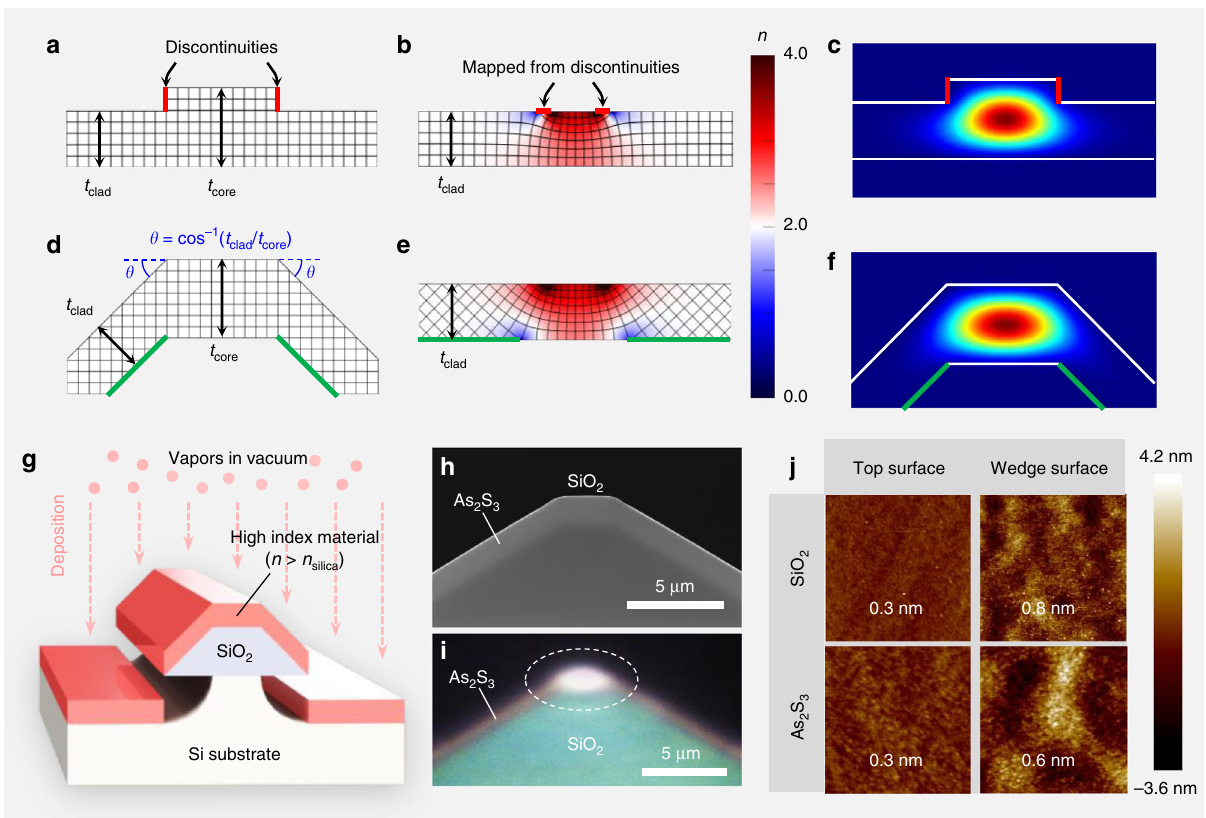
Fig. 1 Design concept of a trapezoidal waveguide and its implementation. a , d A cross-section of a typical rib waveguide and the proposed waveguide without the discontinuities, respectively. The refractive index of the material is set to 2 ( n = 2) without loss of generality. b , e A refractive index pro fi le of the fl at waveguides conformally mapped from the rib and the proposed waveguide, respectively. c, f A simulated optical mode pro fi le of the rib and the proposed waveguides made of As 2 S 3 ( n = 2.43), respectively. g Implementation of the proposed waveguide. By depositing the core material on the SiO 2 platform structure, the waveguide having continuous junctions can be formed. h The cleaved cross-section of the fabricated waveguide observed by scanning electron microscope. i An optical microscope image of the transmitted mode at the output facet. An IR camera image is superimposed with a visible camera image to clearly display the optical mode and waveguide structure. j AFM images showing surface roughness of As 2 S 3 and SiO 2 layers over 2 × 2 μ m 2 area on the top and wedge surfaces of the waveguide. The number shows the rms